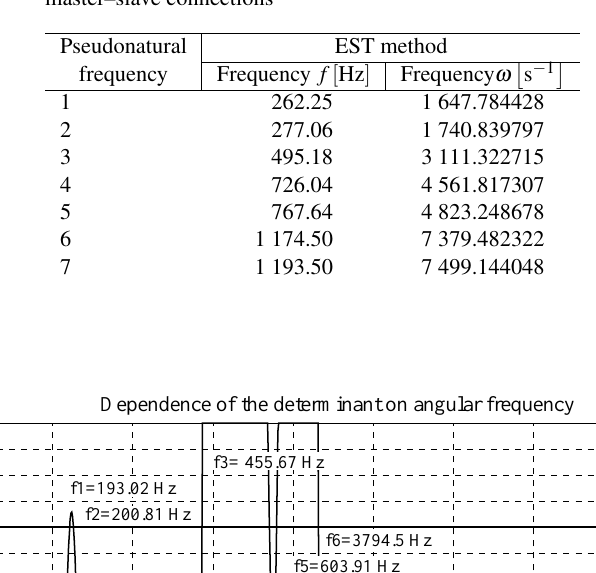
Table 3. Calculation results of the seven-bar truss without